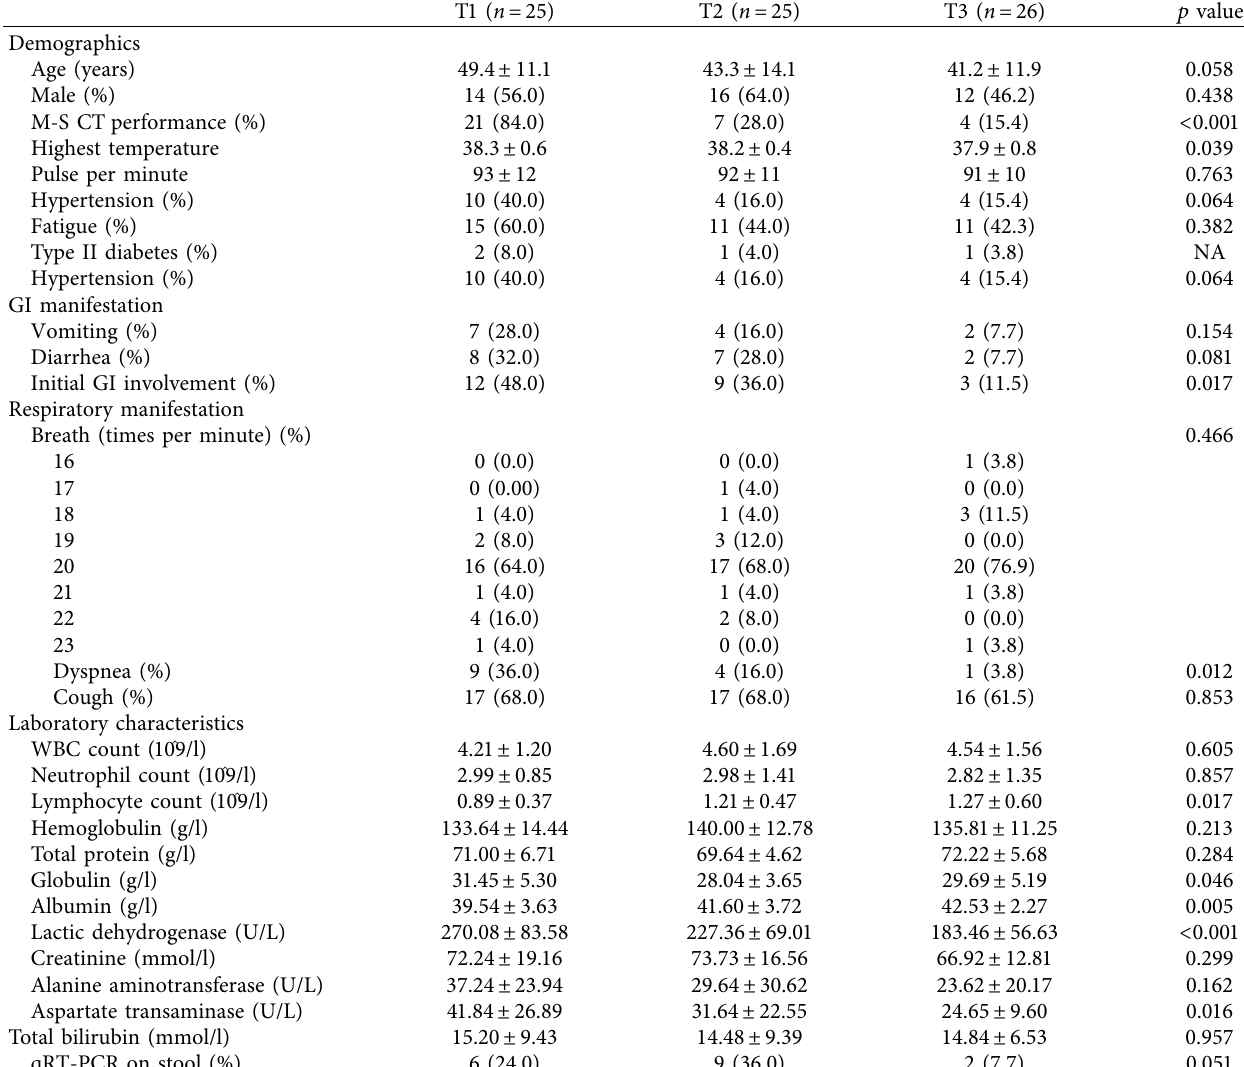
Table 1: Baseline characteristics of included patients, stratified by PC ratio tertiles.